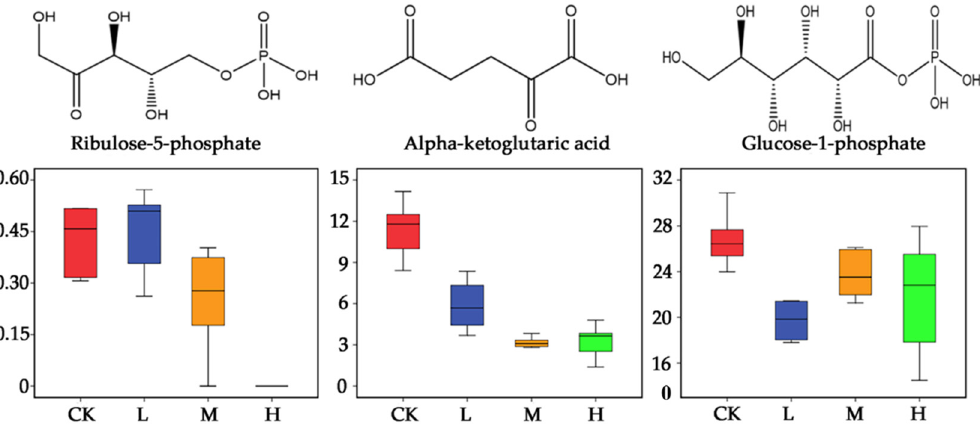
Figure 7. Box plots of relative abundance of energy–related metabolic chemicals of Arabidopsis thaliana treated with aqueous extract of Eupatorium adenophorum. Abbreviations: CK–control; L–treated by aqueous extract in low concentration; M–treated by aqueous extract in medium concentration; H–treated by aqueous extract in high concentration.